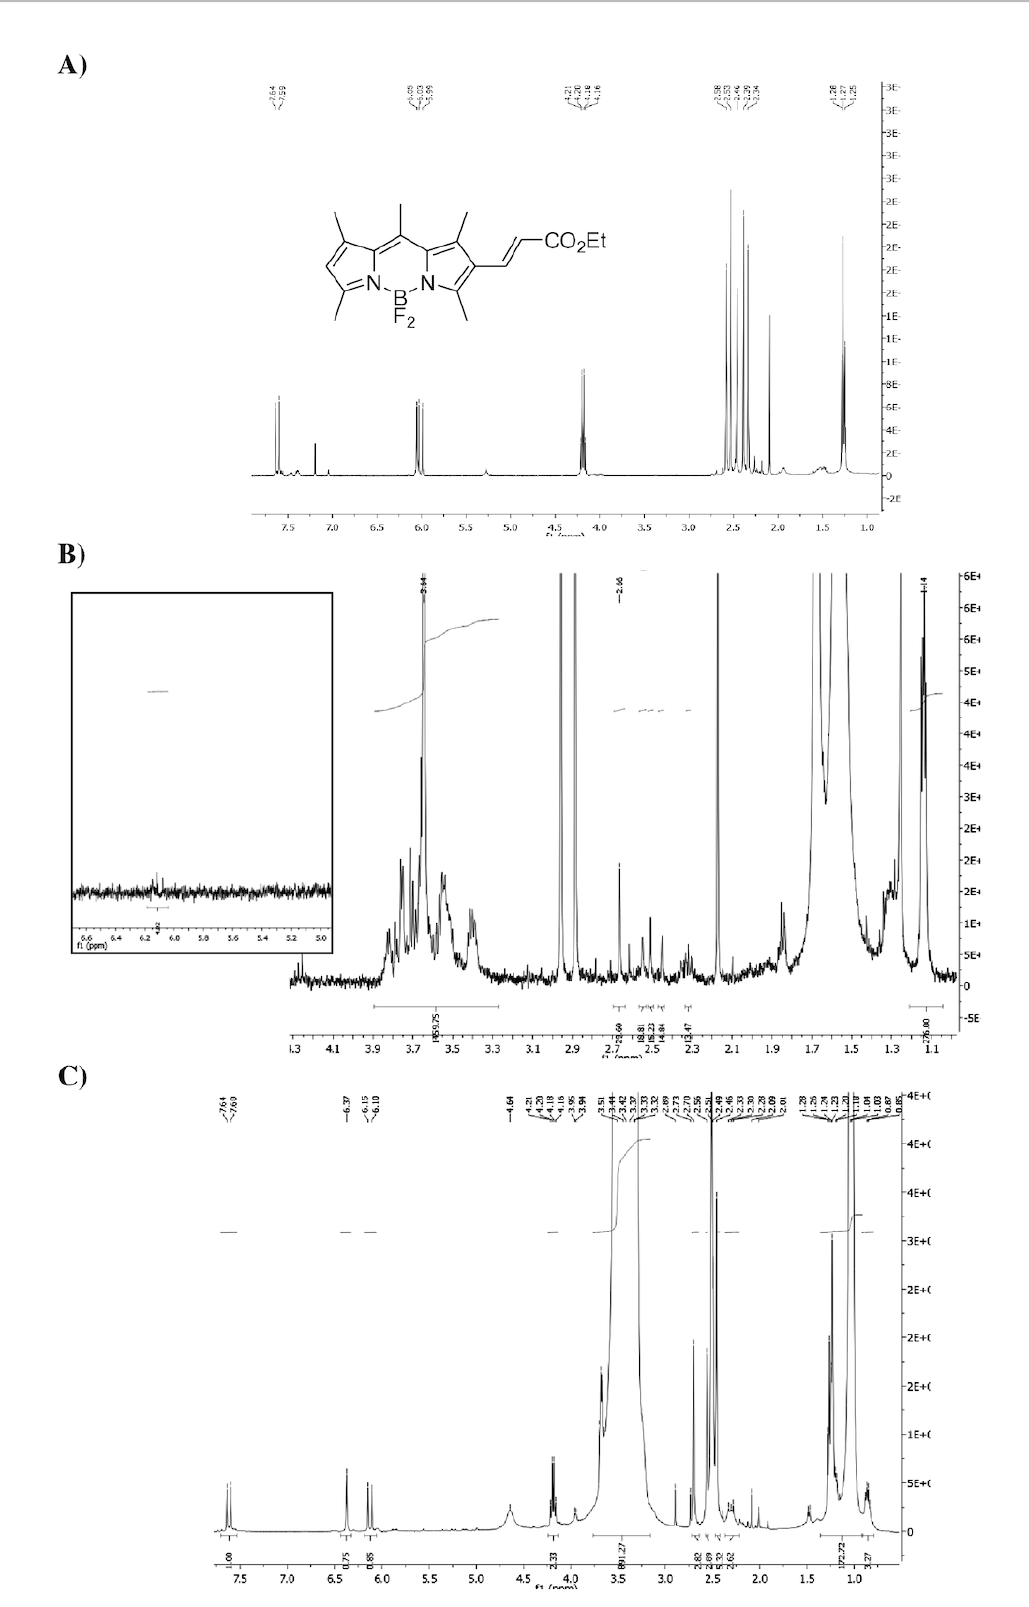
FIGURE 2 – Selected section of 1 H NMR spectra. A) For BODIPY-ester . B) For T1307-BODIPY . Inset: region of the H-pyrrole. C) For L-T1307-BODIPY . In B) and C) residual DMF was observed as doublet in the region near to 2.9